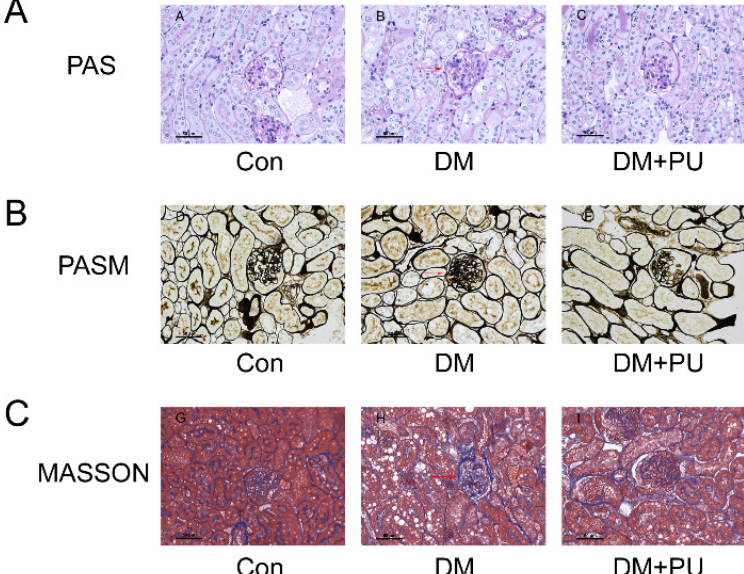
Figure 2. Changes in renal histology of kidney damage. ( A ) PAS sections of the kidney tissues after 8 weeks’ intragastric administration. ( B ) PASM sections of the kidney tissues after 8 weeks’ intragastric administration. ( C ) Masson sections of the kidney tissues after 8 weeks’ intragastric administration (magnification × 400). Table 1. Glomerular tuft area of mice ( 𝑥̅ ± s, n = 8).